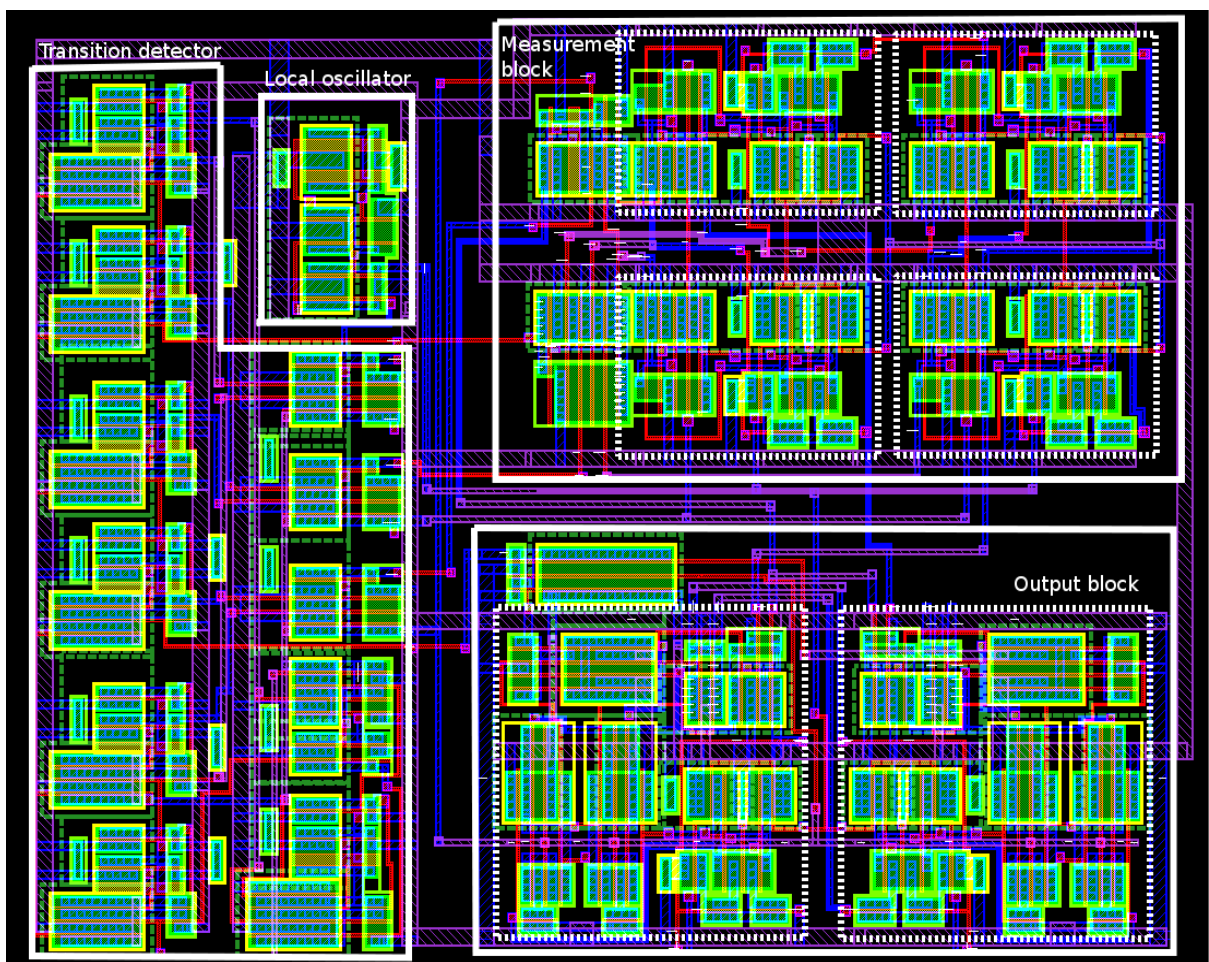
Figure 9. Layout of VLSI sensor with num_delay and m parameters equals to 2 and 3